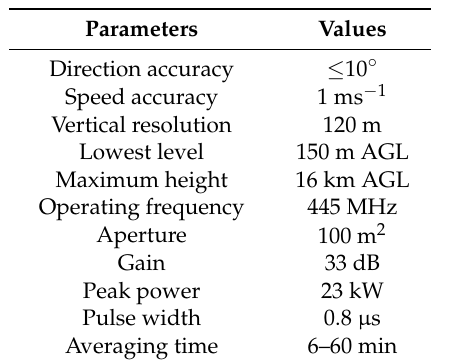
Table 1. Technical specifications of the CFL-16